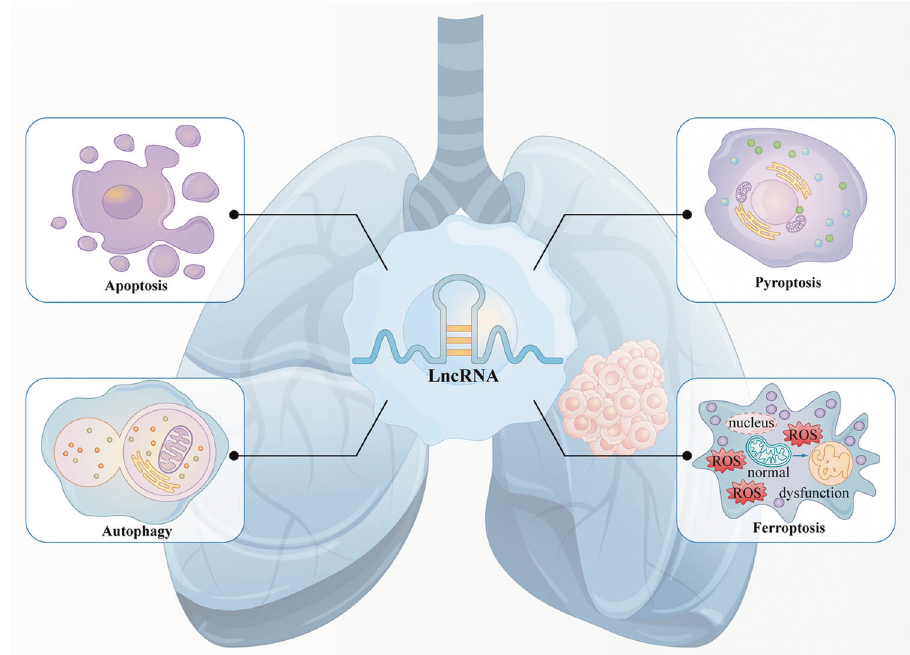
Fig. 1 Relationship between lncRNAs and PCD in NSCLC. PCD plays a critical role in the pathogenesis of NSCLC. LncRNAs are strongly associated with PCD, which can regulate different types of PCD and related pathways to in fl uence the tumorigenesis and cancer progression of